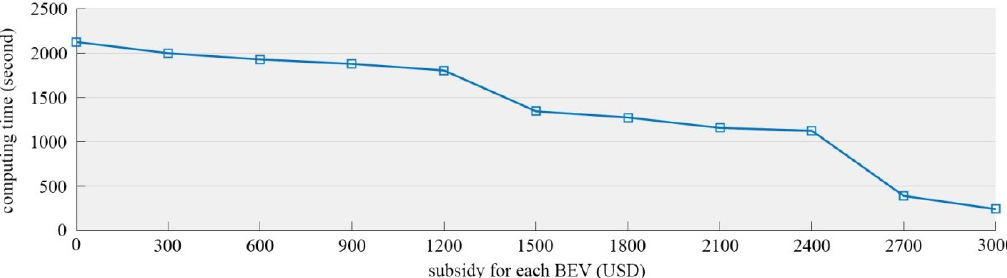
Figure 5. The results of the local search algorithm under different subsidies.